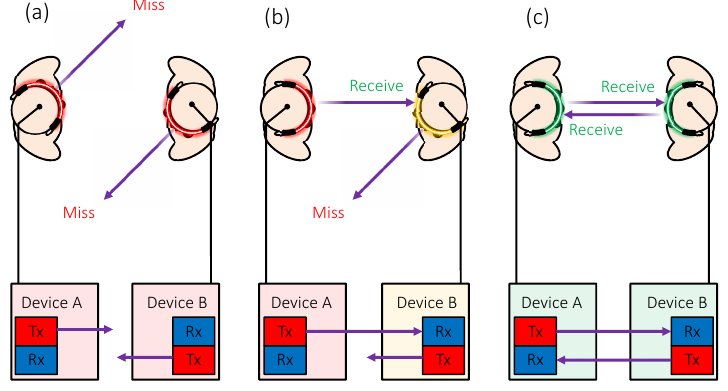
Figure 4. Principle of measuring face-to-face behavior by infrared communication: ( a ) the devices are not face-to-face; ( b ) Device A faces Device B while Device B does not face Device A; and ( c ) the devices are